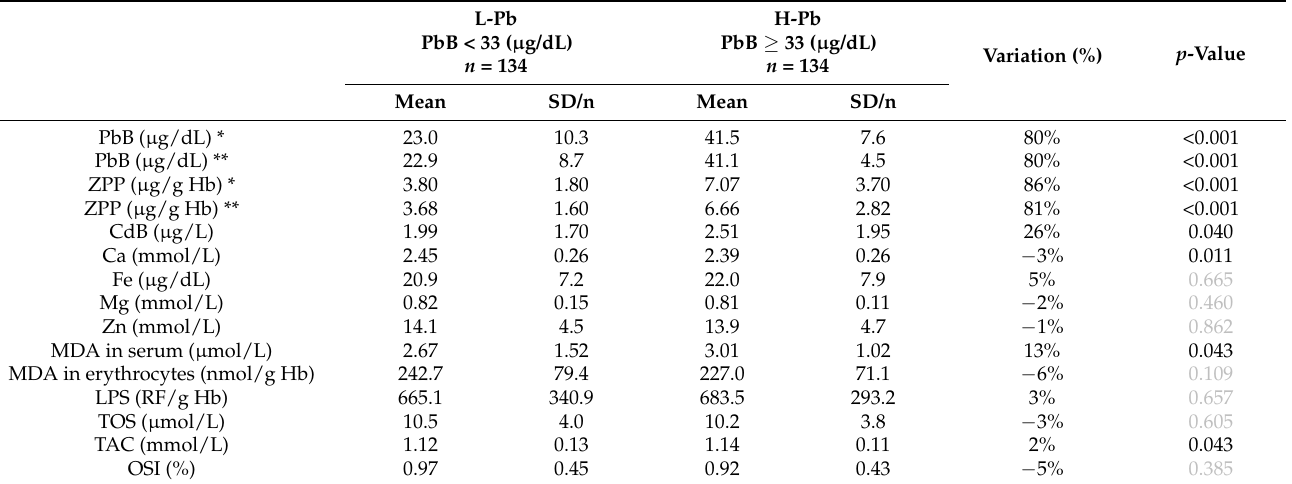
Table 2. Biochemical test